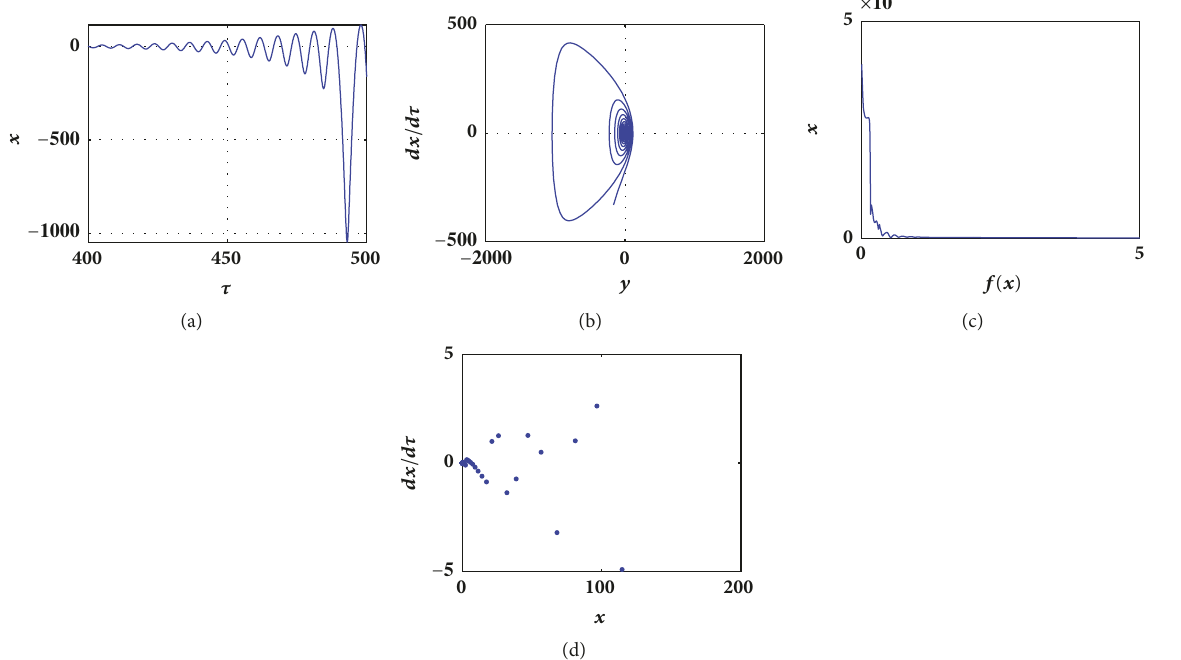
Figure 9: The time history, the phase diagram, spectrum, and the Poincar´e section of the system (6) for 𝜀 = 0.06885 , 𝑄 = −1 .